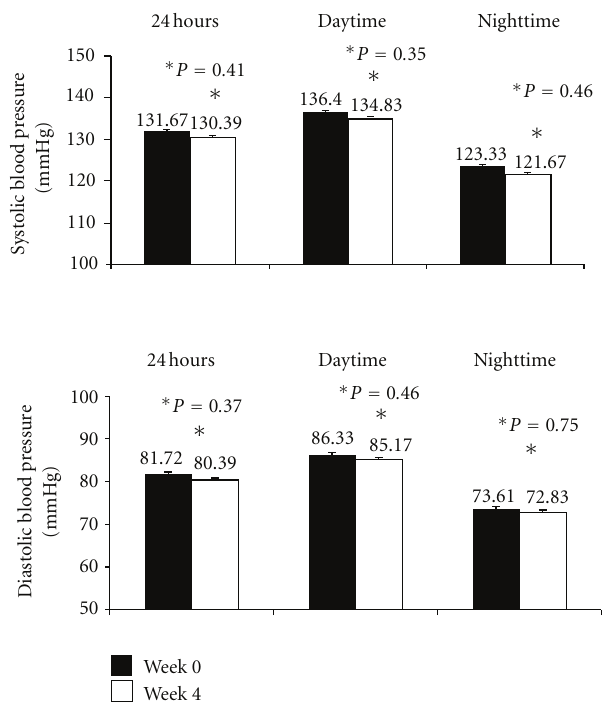
Figure 2: Mean values of systolic and diastolic blood pressure evaluate by ambulatory blood pressure monitoring at baseline (week 0) and at the end of the study (week 4) ( n = 20).